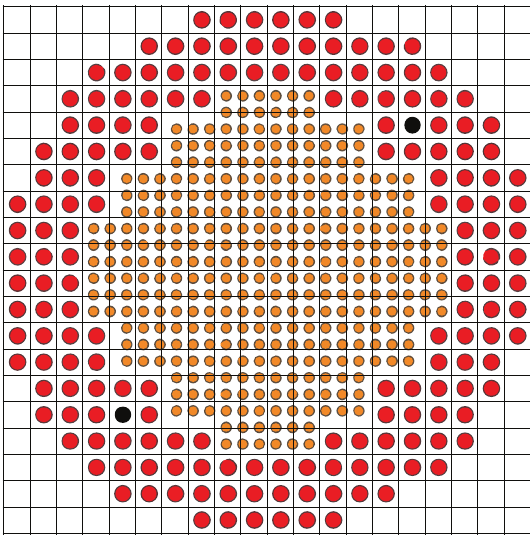
Figure 8: U-metal fuel cell-size